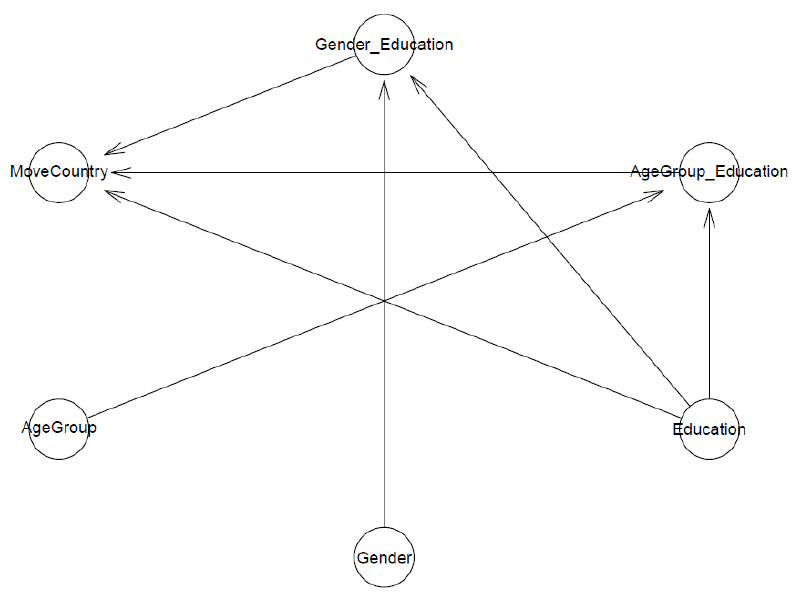
(cid:48) s logical Figure 8. Model 2′s logical network. Figure 8. Model 2 Figure 8. Model 2′s logical network.